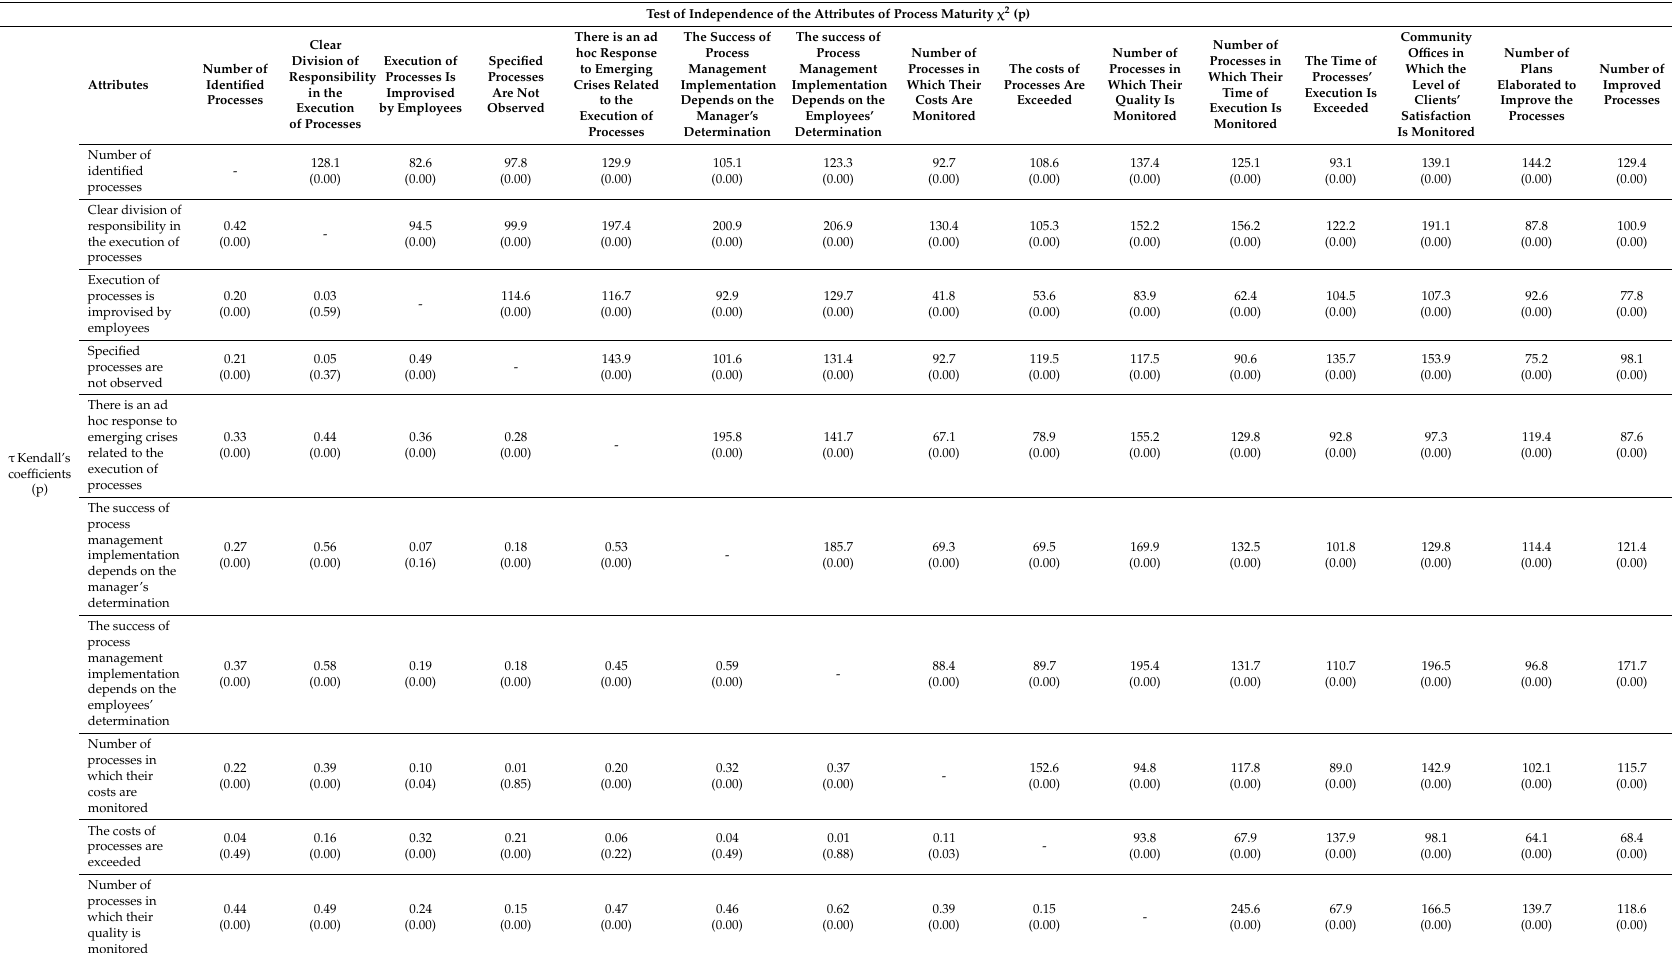
Table 5. Analysis of the dependence of process maturity attributes (n = 174) ( α =